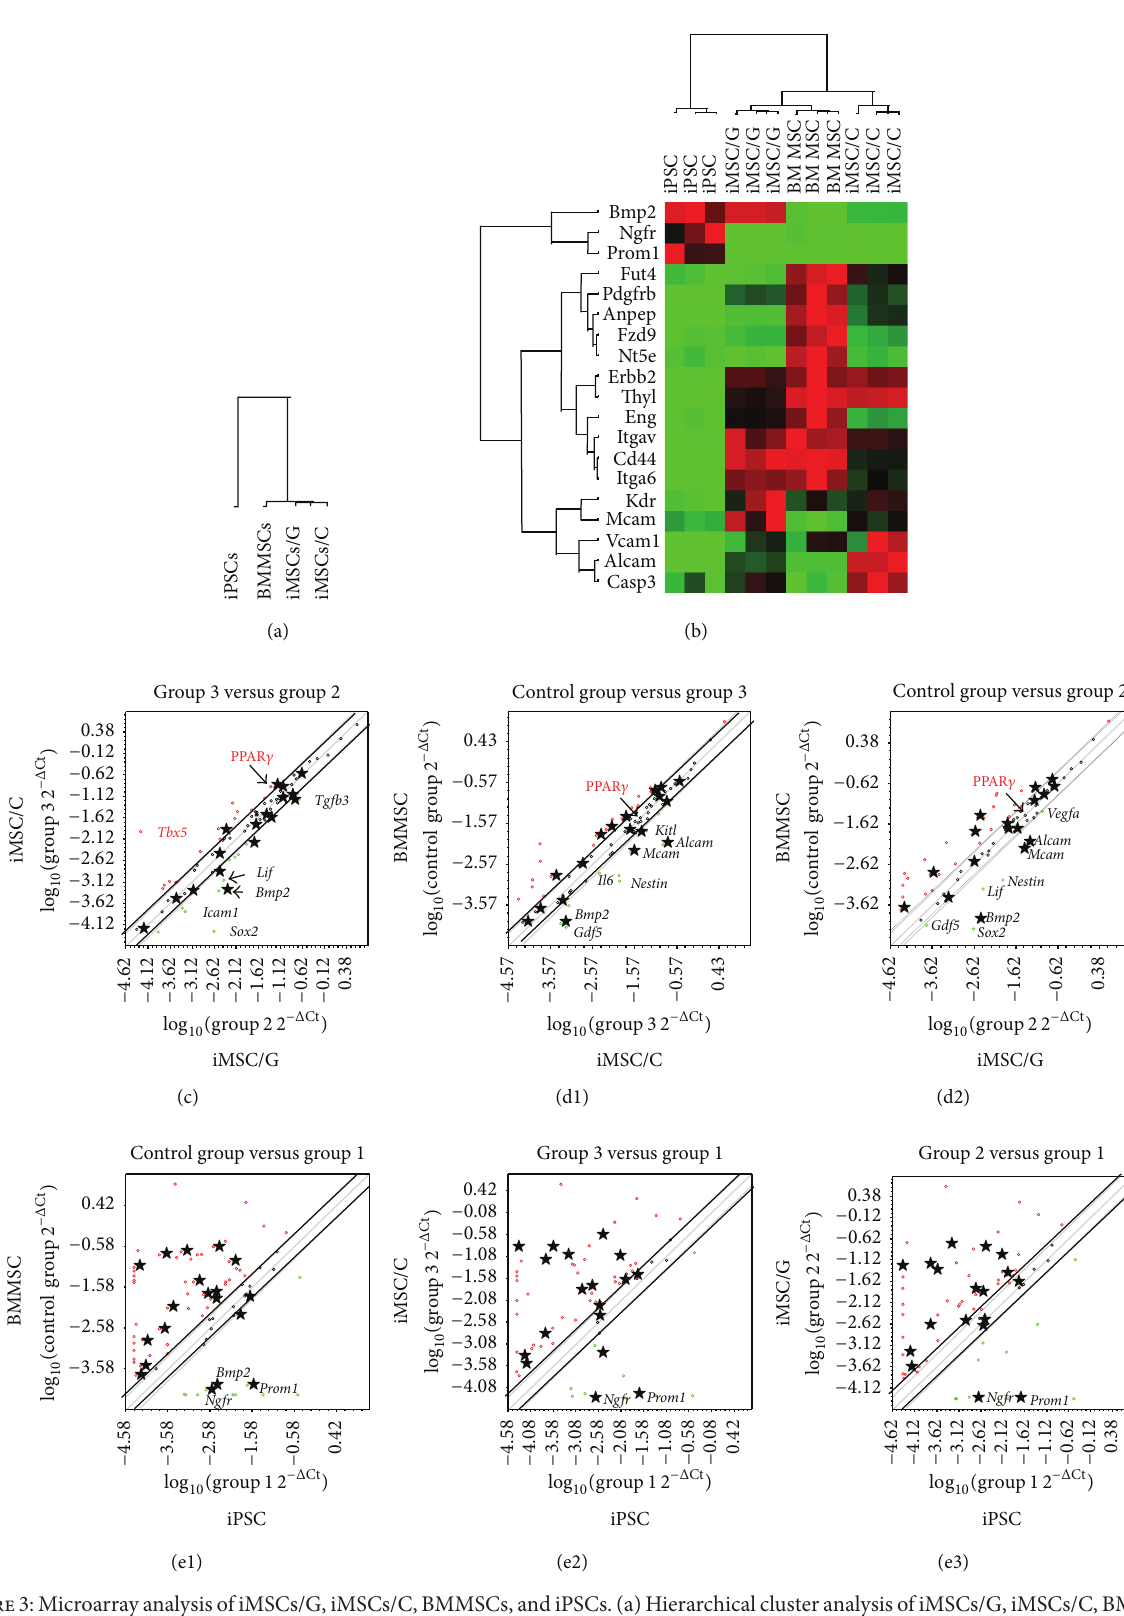
Figure 3: Microarray analysis of iMSCs/G, iMSCs/C, BMMSCs, and iPSCs. (a) Hierarchical cluster analysis of iMSCs/G, iMSCs/C, BMMSCs, and iPSCs by selecting 50 genes with upregulation by 2-fold in BMMSCs relative to iPSCs. (b) Hierarchical clustering analysis of MSC-specific genes of iMSCs/G, iMSCs/C, BMMSCs, and iPSCs. (c-e3) Pairwise scatter plots comparisons of the gene expression profiles of iMSC/C versus iMSC/G (c), BMMSC versus iMSC/C (d1)/iMSC/G (d2), BMMSC versus iPSC (e1), iMSC/C/iPSC (e2), and iMSC/G/iPSC (e3). Diagonal lines indicate the boundaries of twofold changes in gene expression. Gene expression levels are shown on log 10 scale. MSC-specific genes: stars ( ‰